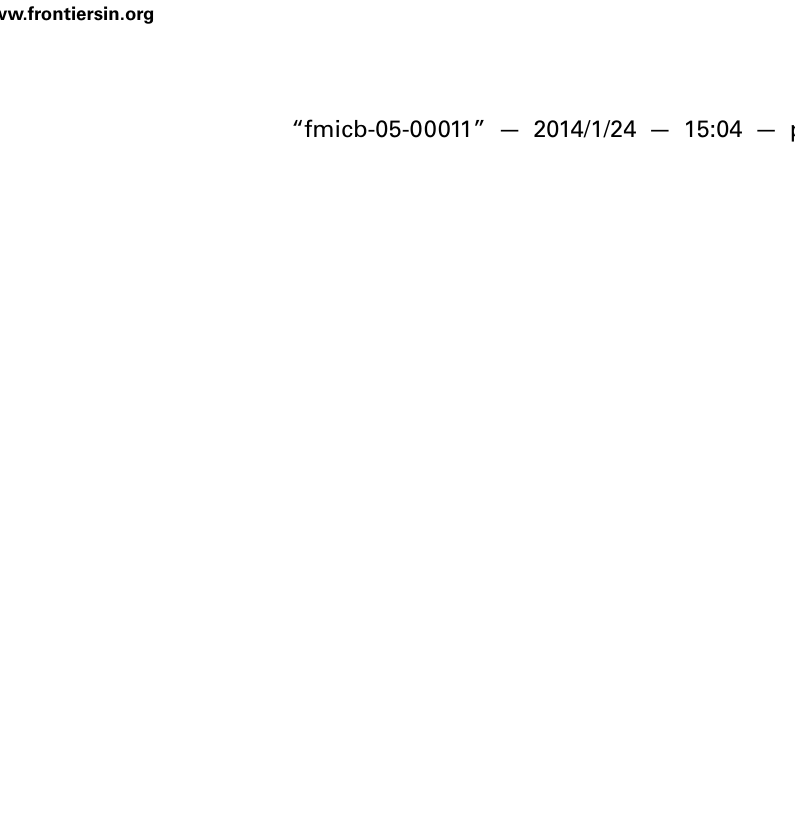
FIGURE 7 | Distribution of phyla for the microbial mat sample (A) and microelectrode tip sample (B).